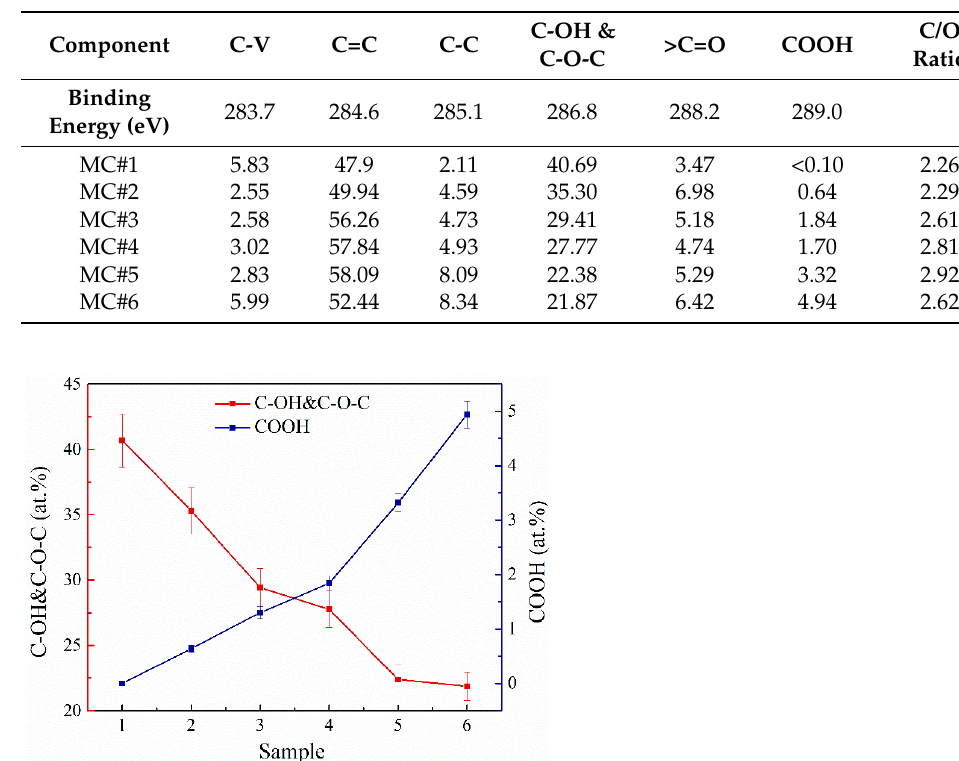
Table 2. C/O ratio, and the composition of the functional groups and carbon atoms in the graphene network (in at.%) in the MC#1–MC#6 films derived from the analysis of the deconvoluted C 1s X-ray photoelectron spectra.